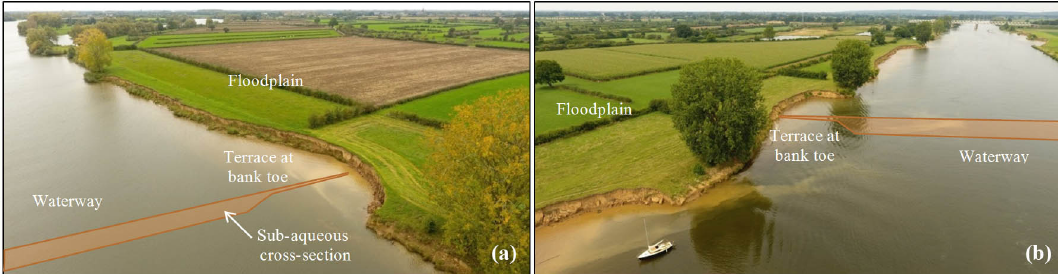
Figure 2. Restored bank in the Meuse River: upstream view of first 300m (a) and downstream view of middle 500m (b) . Bank erosion has caused a series of bays in the 1200m restored reach. Note eroded bank sediment in suspension.